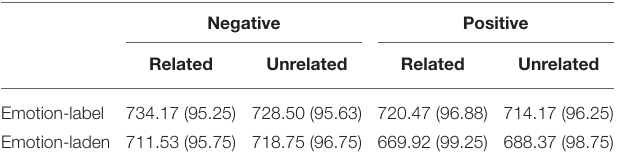
TABLE 3 | Mean reaction time (ms) and accuracy rate (%) of emotion-label words and emotion-laden words in brackets as a function of relatedness and